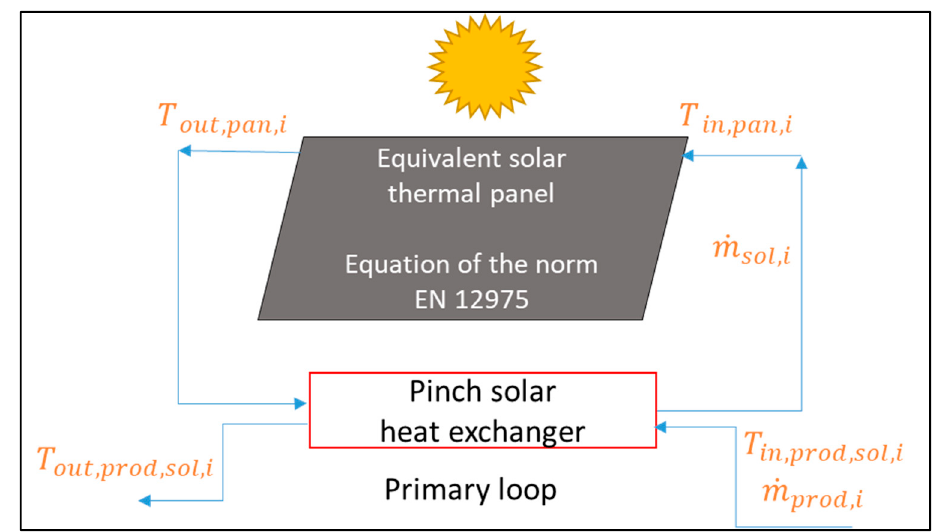
Figure 3. Schematic diagram of the solar thermal model.